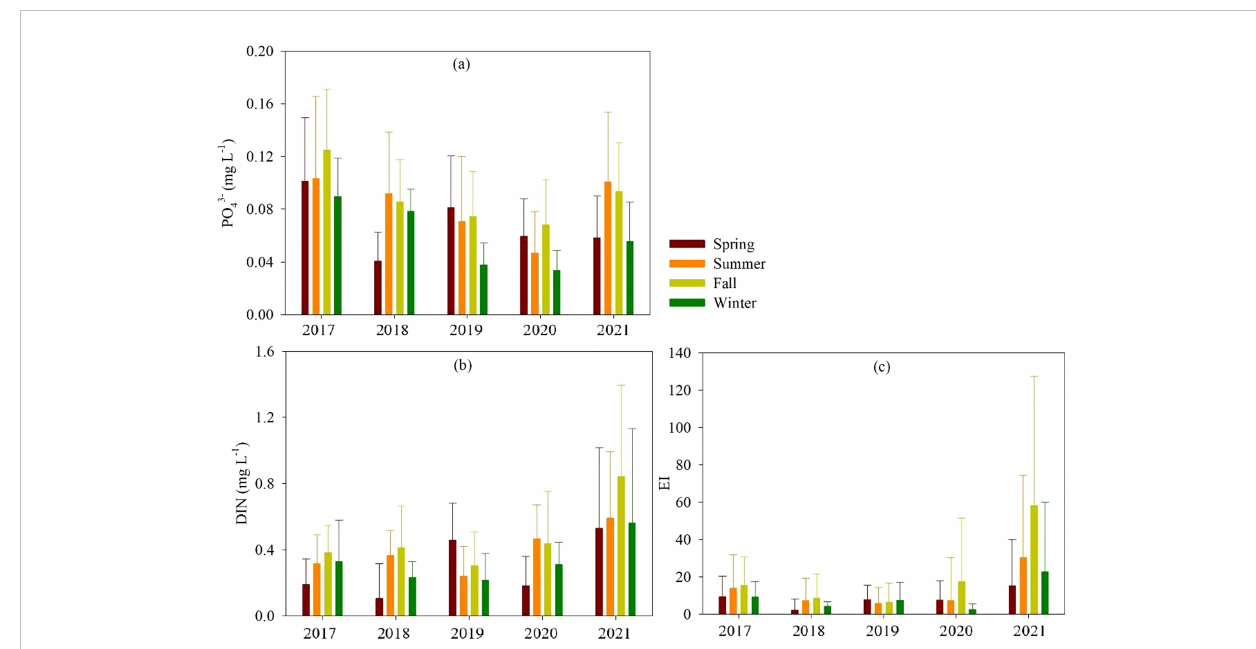
FIGURE 3 Seasonal distributions of nutrients and eutrophication index in Zhanjiang Bay from 2017 to 2021.